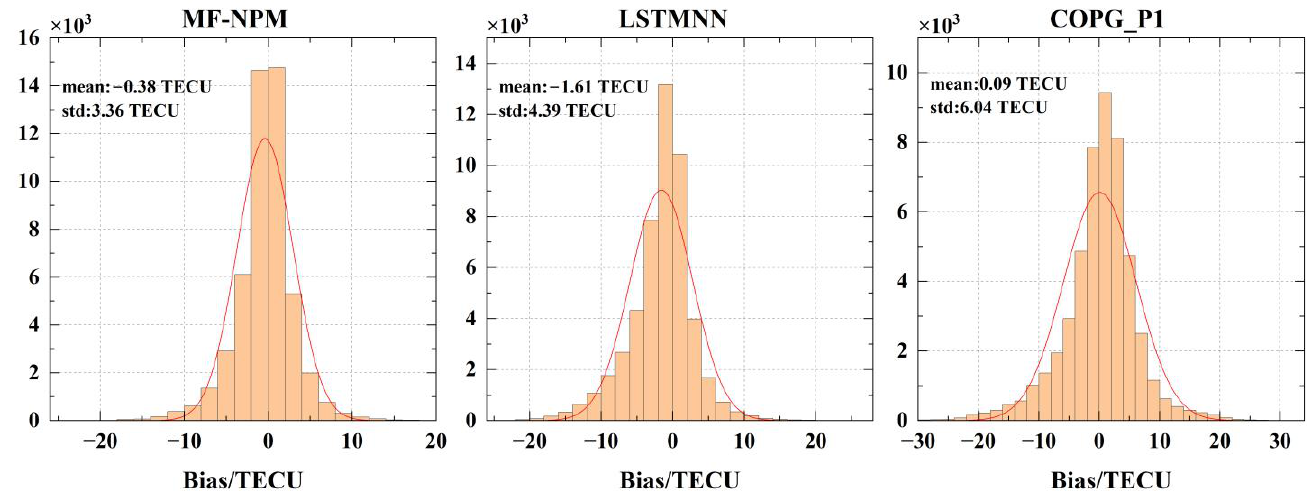
Figure 7. The variations of ( a ) MTEC and ( b ) DMTEC relative to IGS during geomagnetic storms period.